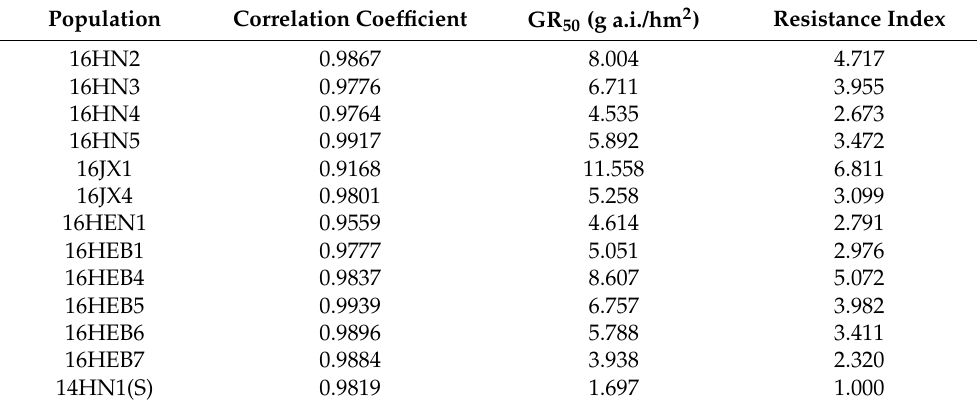
Table 3. The different resistance levels of D. sanguinalis populations to haloxyfop-P-methyl in cotton fields